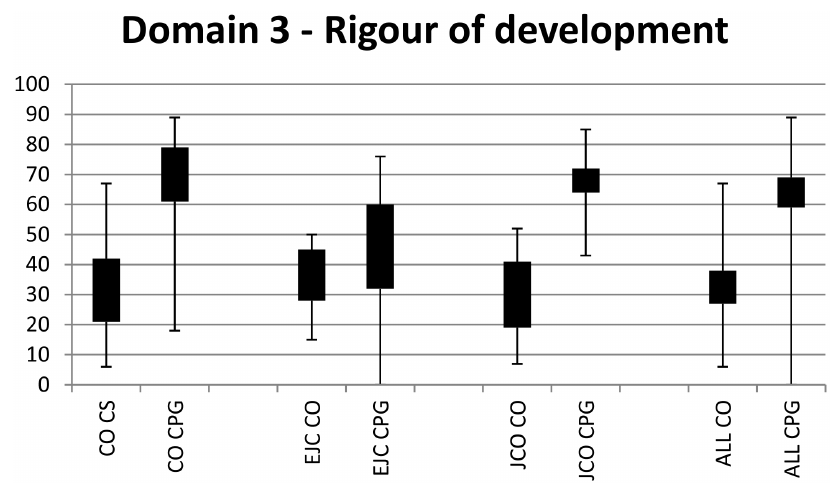
Figure 1. Range and 95% confidence intervals for Rigour of development scores. CO=Current Oncology. EJC=European Journal of Cancer . CS=Consensus statements. JCO=Journal of Clinical Oncology . CPG=Clinical practice